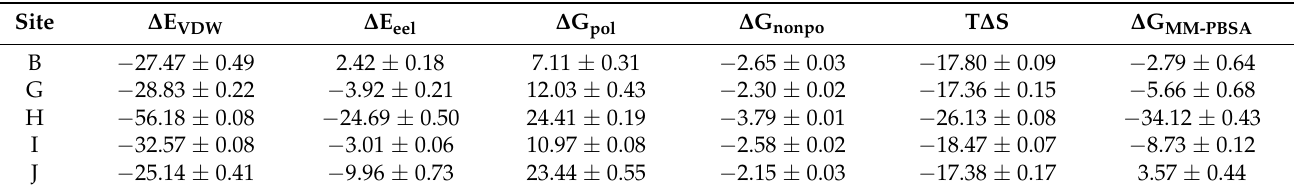
Table 3. Energy decomposition of MM-PBSA-WSAS free energy for C-2 binding to CB2 with CP55940 residing in the orthosteric site. All energies are in